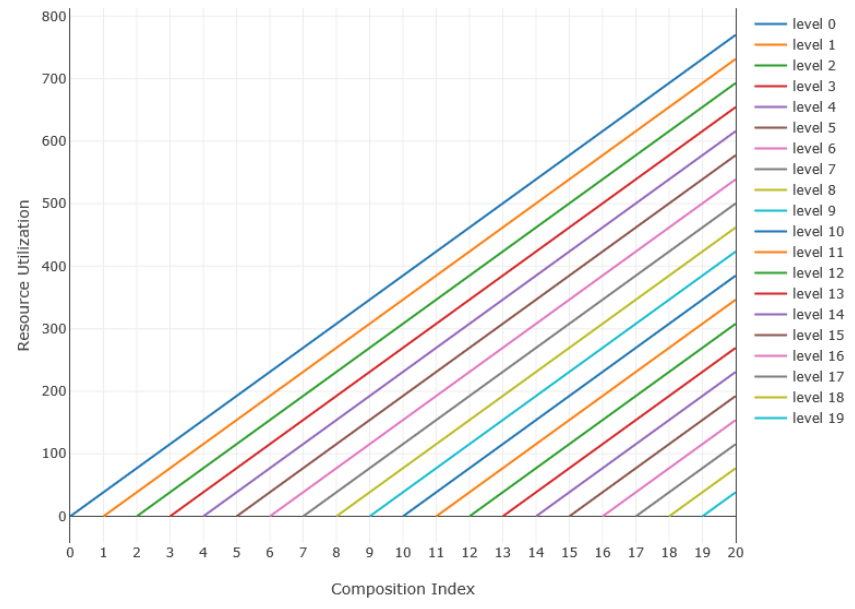
Figure 4. Cumulative resource utilization as estimated from each composition index (l).